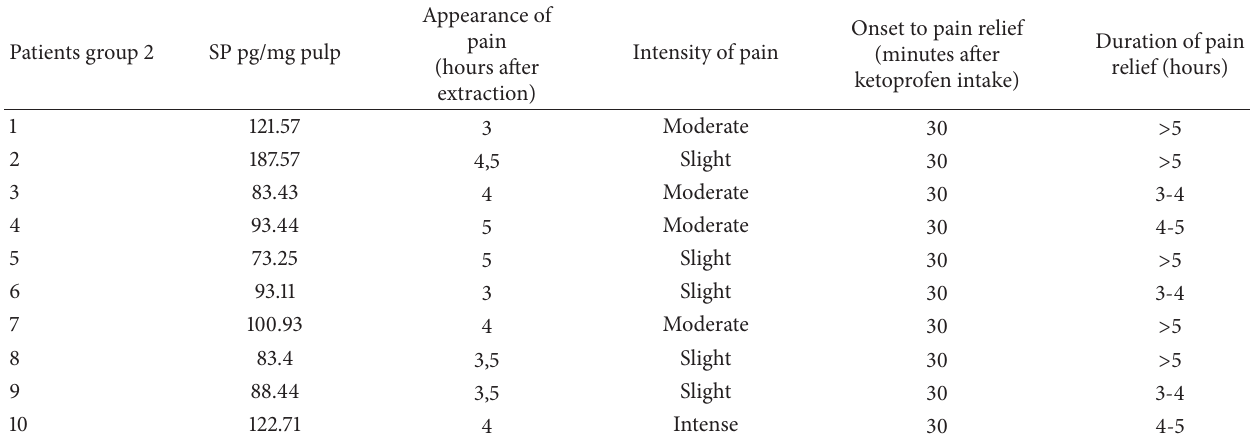
Table 2: Substance P and pain evaluation after tooth extraction of upper third molars with experimentally induced pulpal lesion, in patients with no drug administration before the procedure.